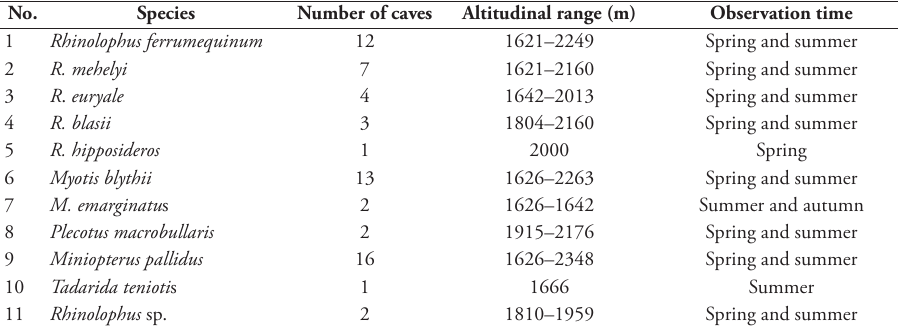
Table 2. The number of caves for each species, as well as their altitudinal ranges and observation time. No.